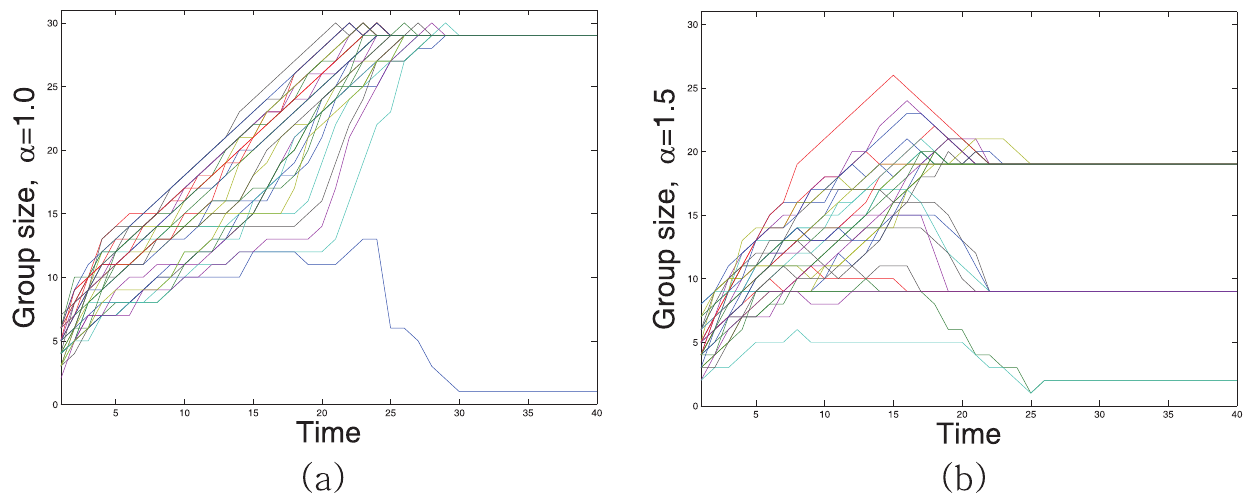
Figure 3. Group division according to the parameter a . The initial ratio of liking among people is 1/3. When a =1 as in (a), 30 People join together likely making an outcast. In (b), a =1.5 and people break into three groups of 19, 9 and